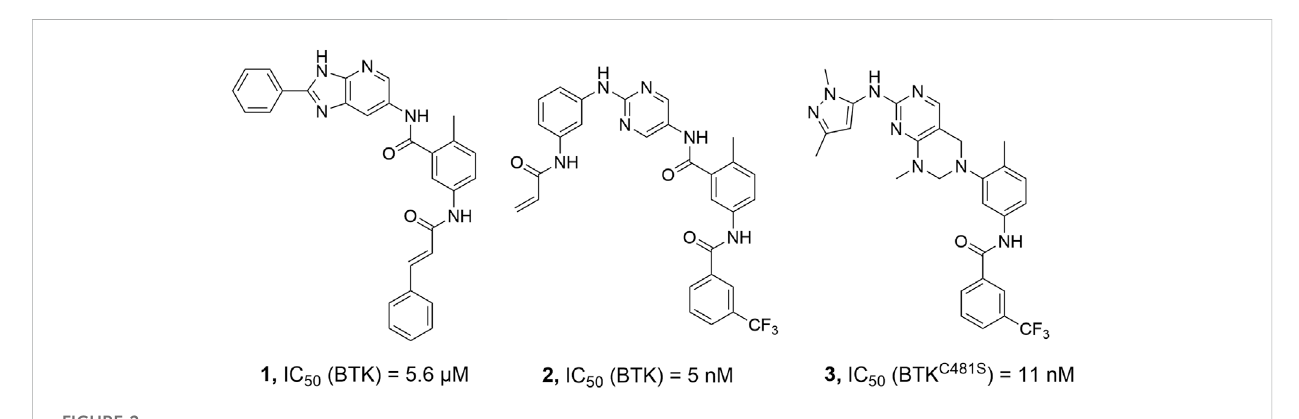
FIGURE 2 Representative BTK inhibitors with type II